Question: Describe this figure in one sentence.
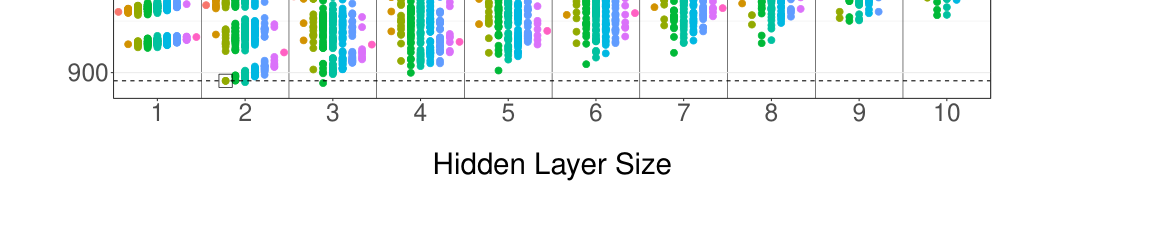
Answer: Dublin Airbnb: BIC of models for different input-layer and hidden-layer com- binations. Points are coloured according to the input layer size. The model selected by our procedure is enclosed in a box and the horizontal dashed line indicates the BIC for this model.